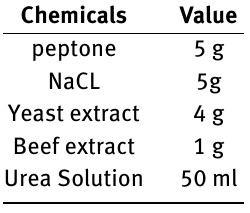
Table 3: Growth media